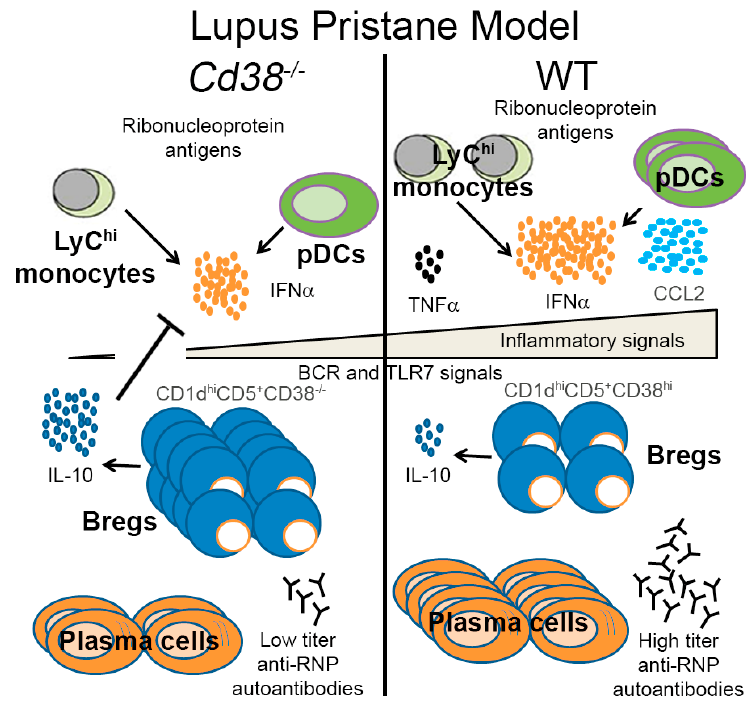
Figure 6. Model for pristane-induced lupus. This model is a modification of that proposed by Menon et al. [30], for human SLE, and it is based on our own previous results on the pristane-induced lupus model [17], and on the results shown in the current study.